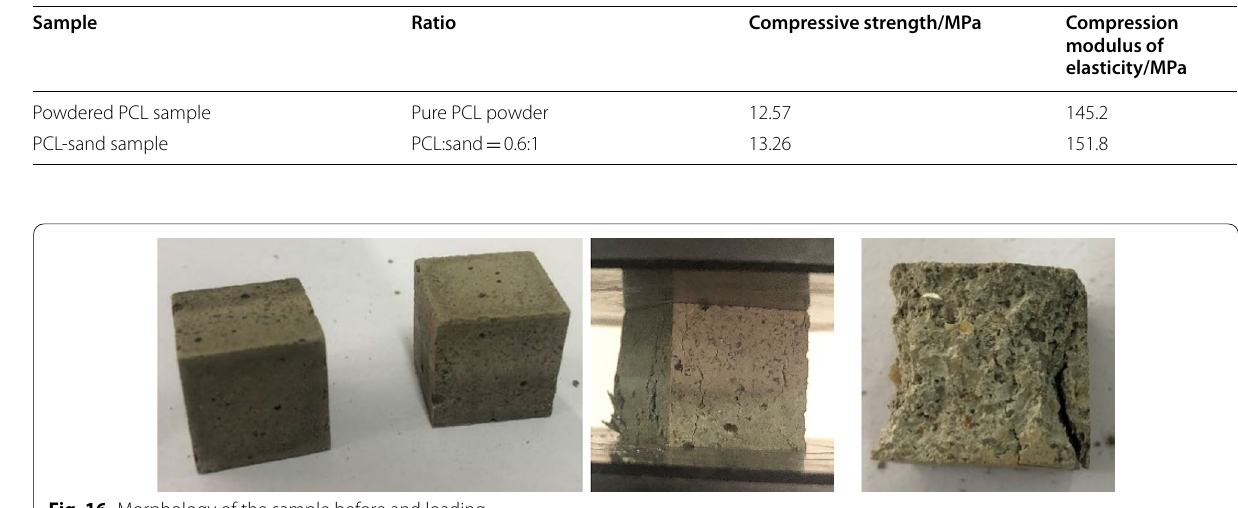
Fig. 16 Morphology of the sample before and loading.